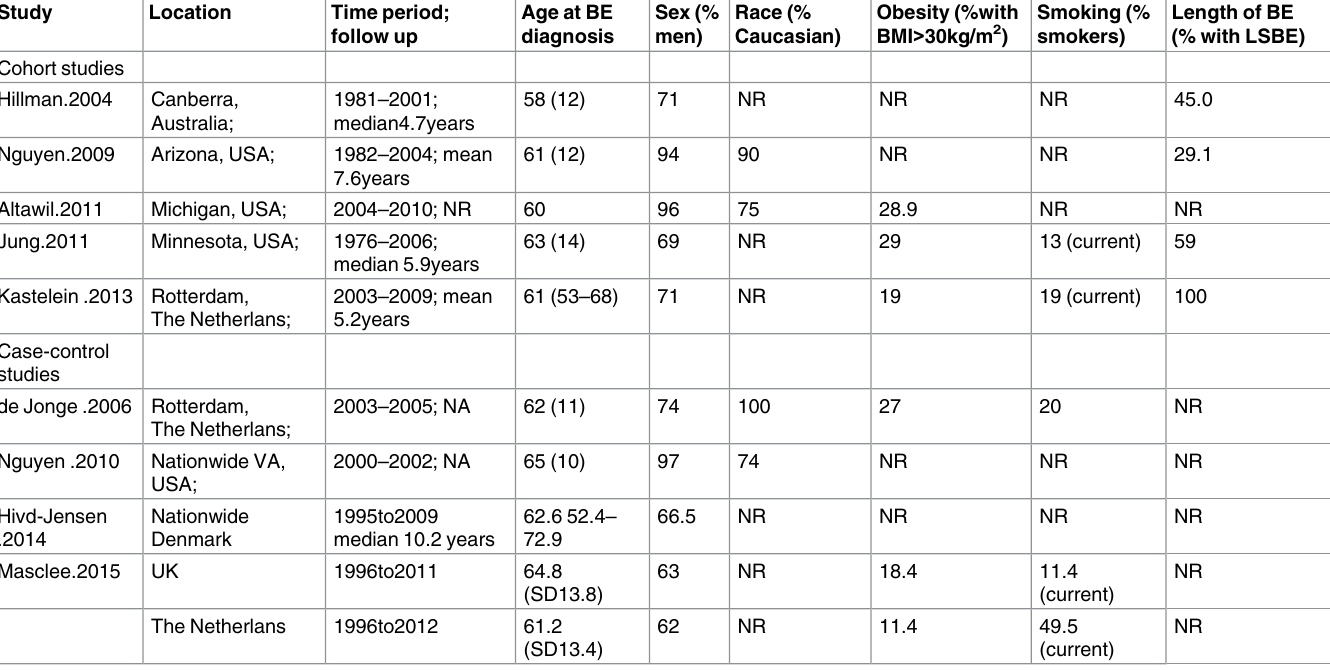
Table 1. Characteristics of individual studies included in the search.